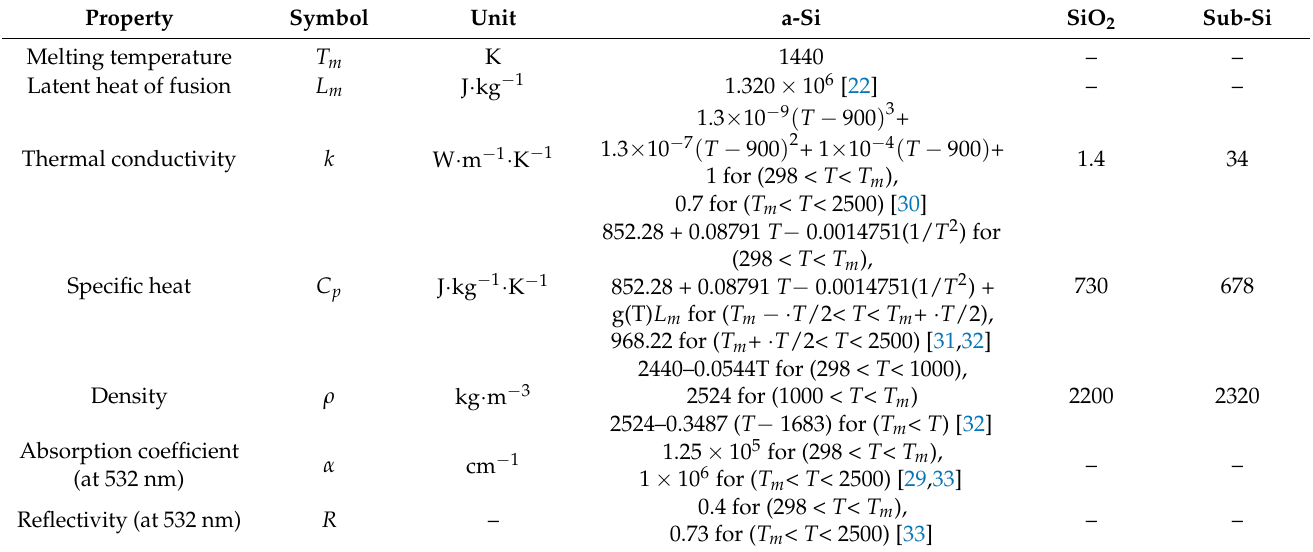
Table 3. Thermophysical and optical properties used in the